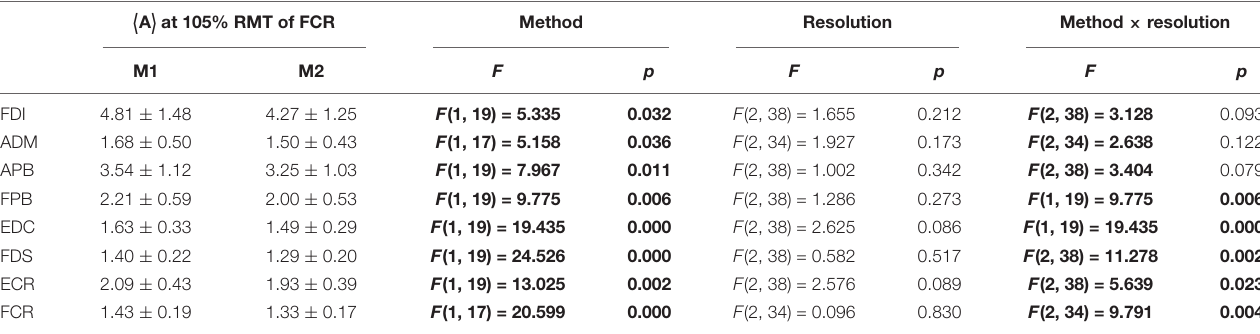
*Bold face implies p < 0.05. TABLE 3 | The outcome of the two-way ANOVA for the area sizes A (in mm 2 · µ V · 10 5 ) with factors of method and resolution for the intensity of 105% RMT of FCR; M1, ignoring non-MEP points, M2, removing them*. (cid:10) A (cid:11) at 105% RMT of FCR Method Resolution Method × resolution M1 M2 F p